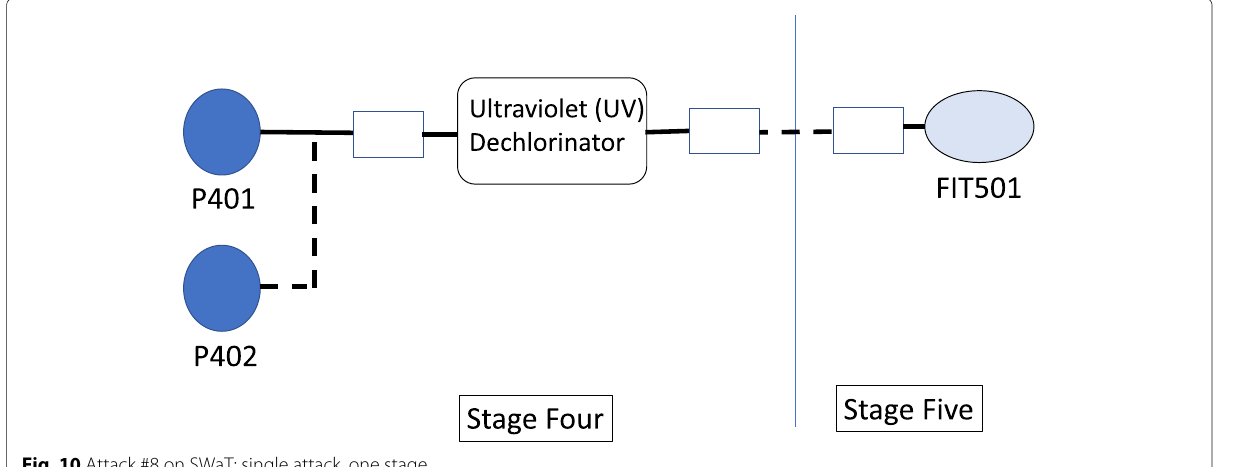
Fig. 10 Attack #8 on SWaT: single attack, one stage